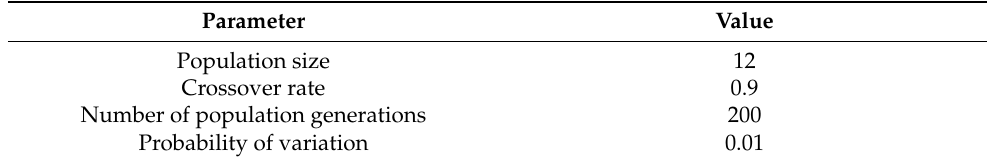
Table 1. Parameter settings of algorithm. Parameter Value Parameter Population size Crossover rate 0.9 Number of population generations 200 Probability of variation